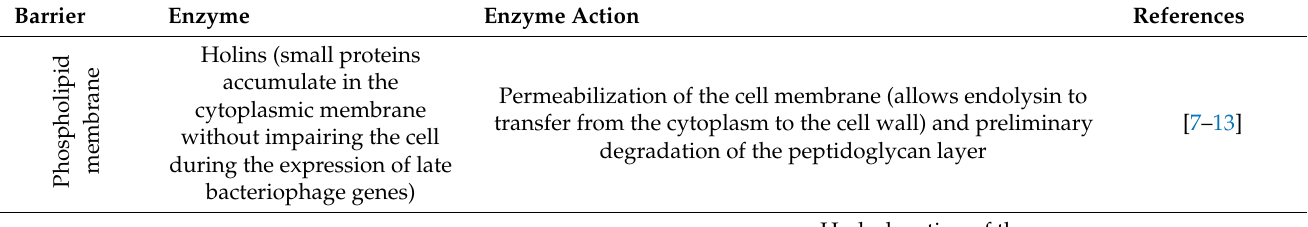
Table 1. Enzymes involved in bacterial cell destruction during the lytic cycle of the